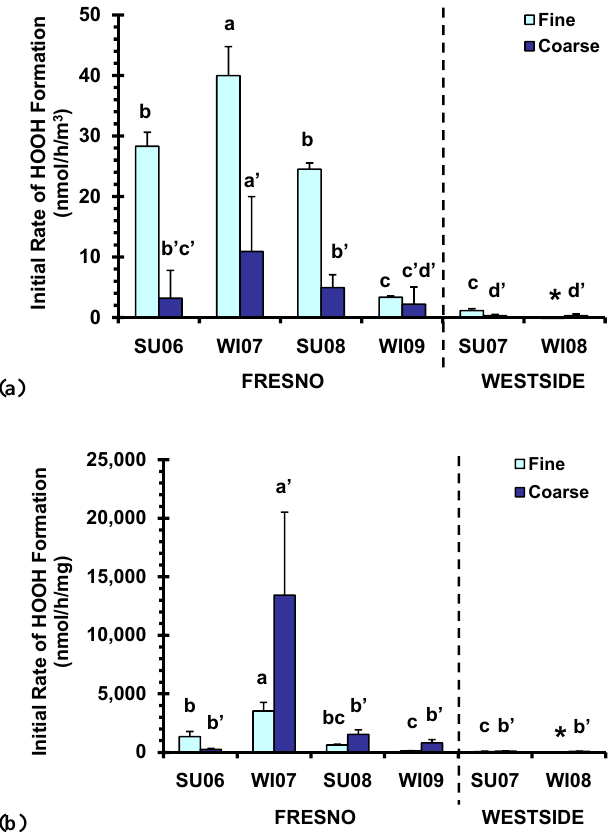
Fig. 2. Rates of HOOH generation in the presence of 50µM ascor- bate. (a) shows air-volume-normalized initial rates of HOOH for- mation, while (b) shows PM-mass-normalized initial rates. Val- ues are means ± SD, n = 3. Letters above bars indicate statisti- cally different rates: a > b > c for fine PM, while a 0 > b 0 > c 0 > d 0 for coarse PM. The asterisk for the WEWI08 sample indicates that HOOH formation was not statistically different from